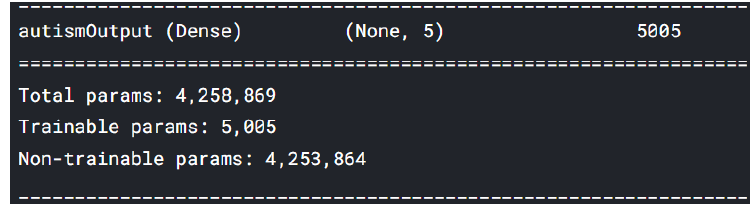
Figure 7. Last layer model summary.